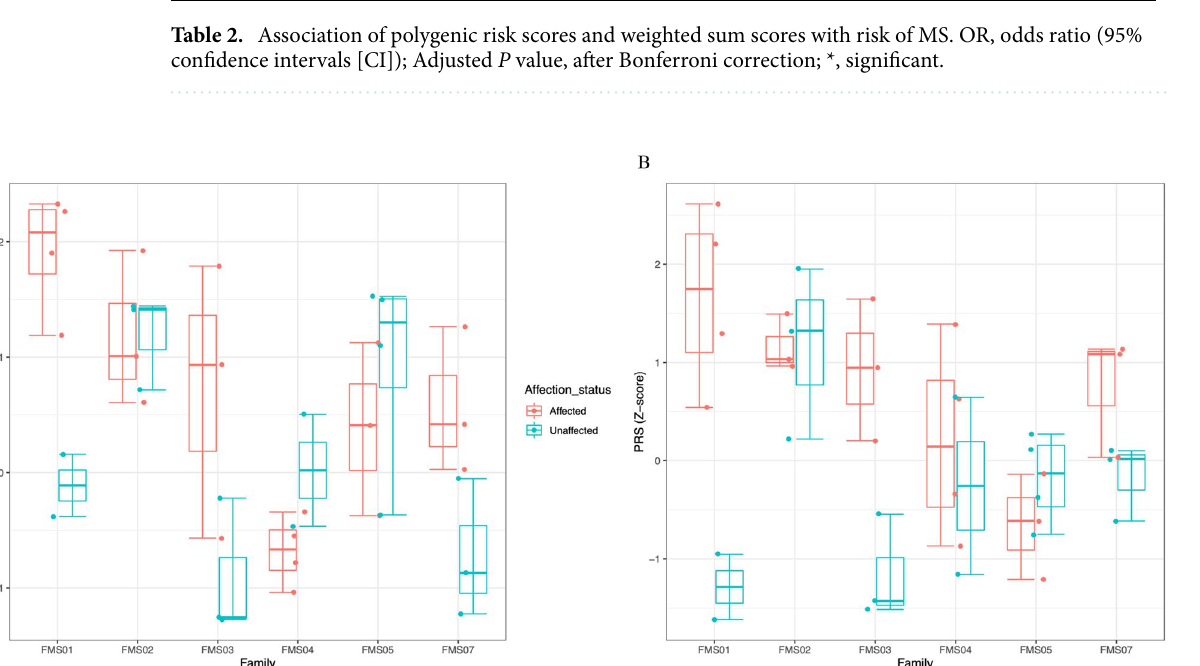
Figure 4. Box plots showing the weighted sum score and polygenic risk score (PRS) distributions in MS families. (A) Weighted sum scores including both MHC and non-MHC alleles of each affected and unaffected member in MS families. (B) PRS of each affected and unaffected member in MS families. Each data point represents the genetic risk score of an individual. Boxes are mean ± 1.5 × interquartile